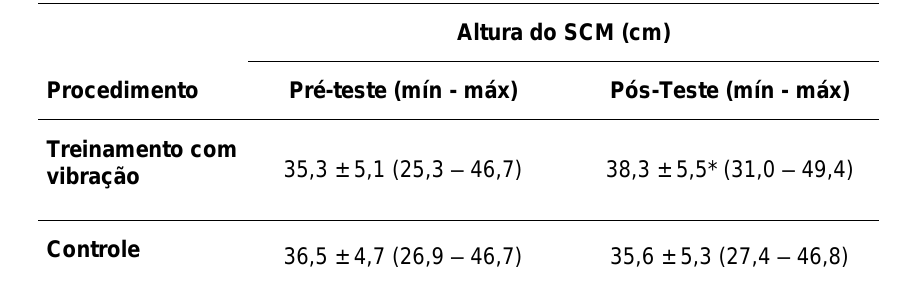
Tabela 1. Média e desvio padrão dos resultados de saltos verticais obtidos no pré e pós-teste para as condições treinamento com vibração e